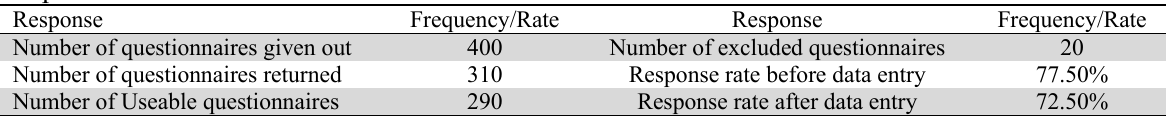
Response Rate Response Frequency/Rate Response Frequency/Rate Number of questionnaires given out 400 Number of excluded questionnaires 20 Number of questionnaires returned 310 Response rate before data entry 77.50% Number of Useable questionnaires 290 Response rate after data entry